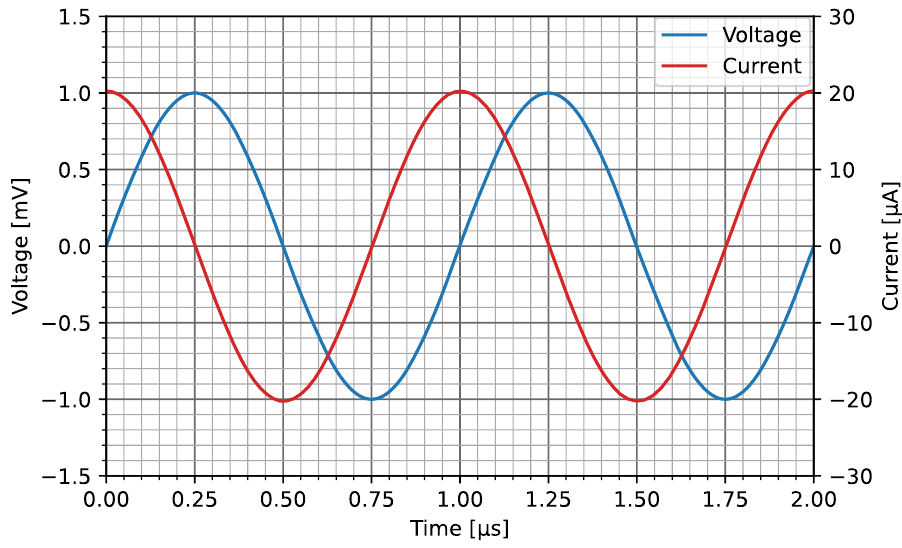
Figure 29. LTspice simulated voltage and current plots for an input signal of 1 mV at 1